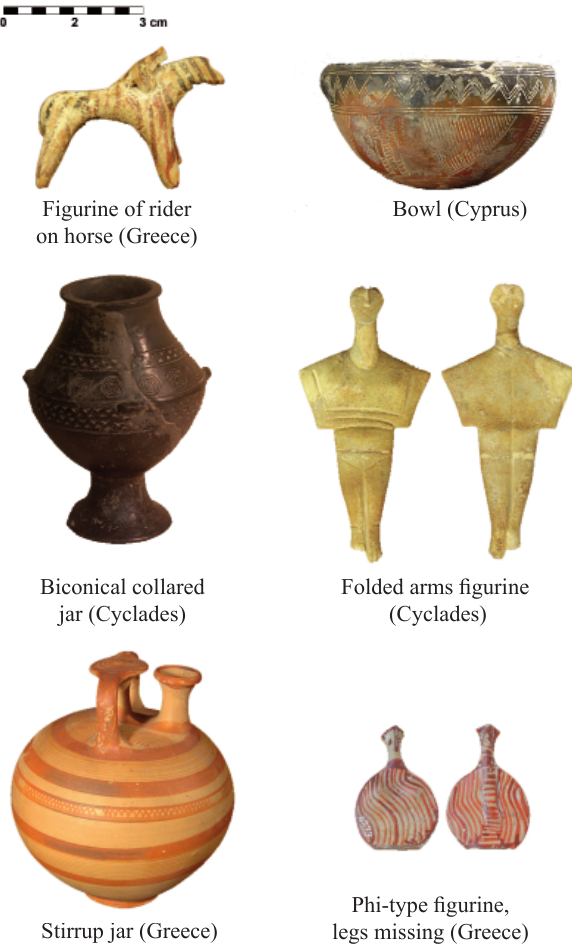
Figure 1. Photos of a few holdings of the National Archaeological Museum in Florence, which have